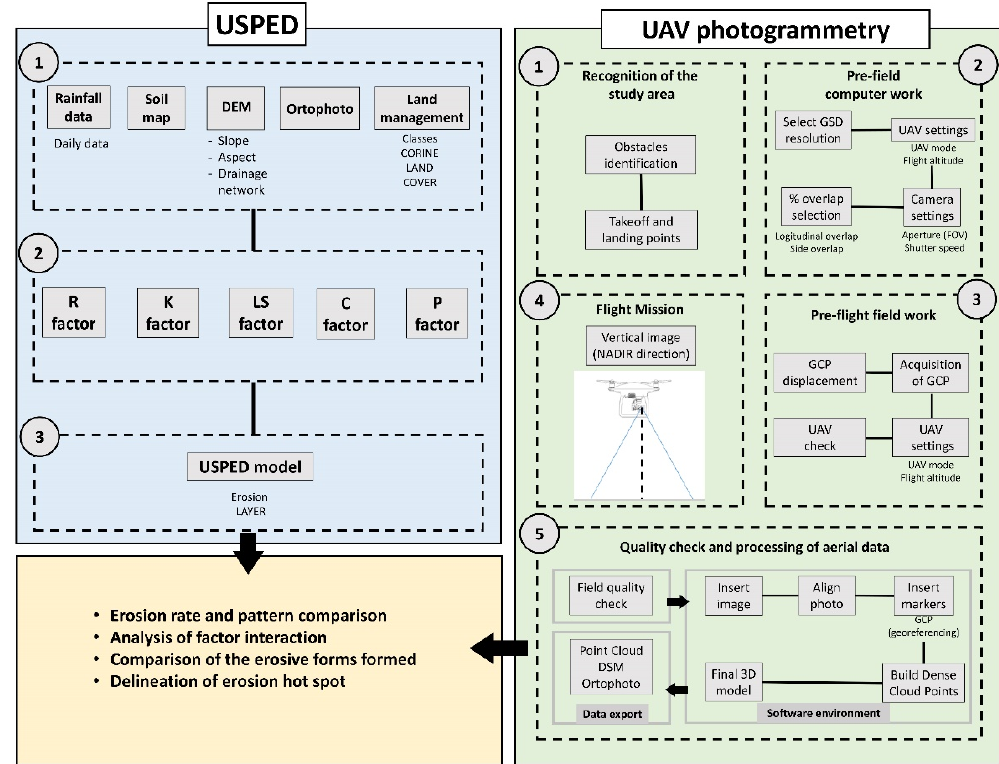
Figure 2. Workflow for the USPED model application and UAV mapping. USPED: (1) data collection; (2) calculation of the model parameters; (3) erosion risk map. UAV photogrammetry: (1) recognition of the study area; (2) pre-field computer work; (3) pre-flight field work; (4) flight mission; (5) quality check and the processing of aerial data.